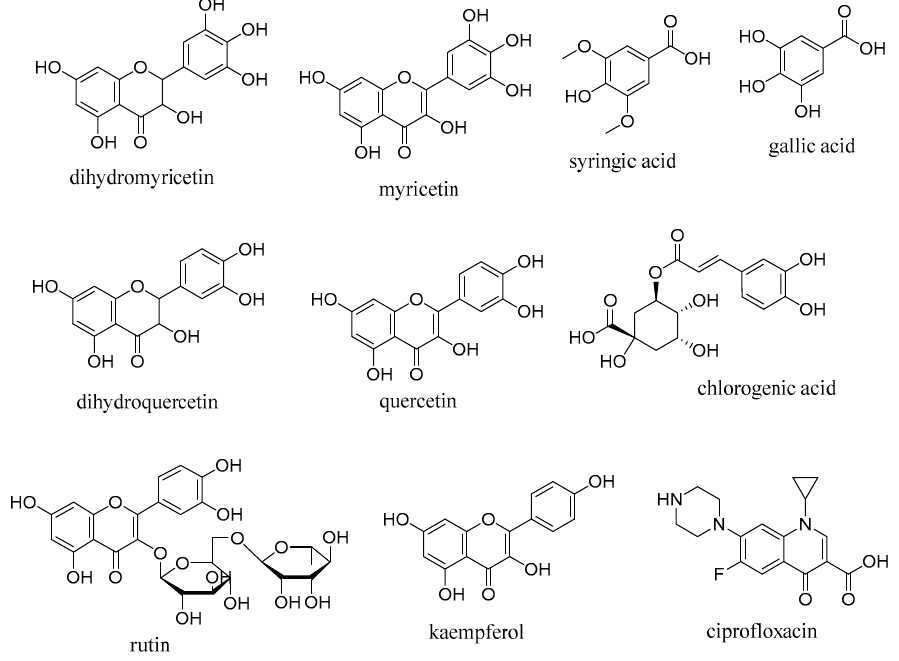
Figure 5. Structures of ligands selected for the in silico study.